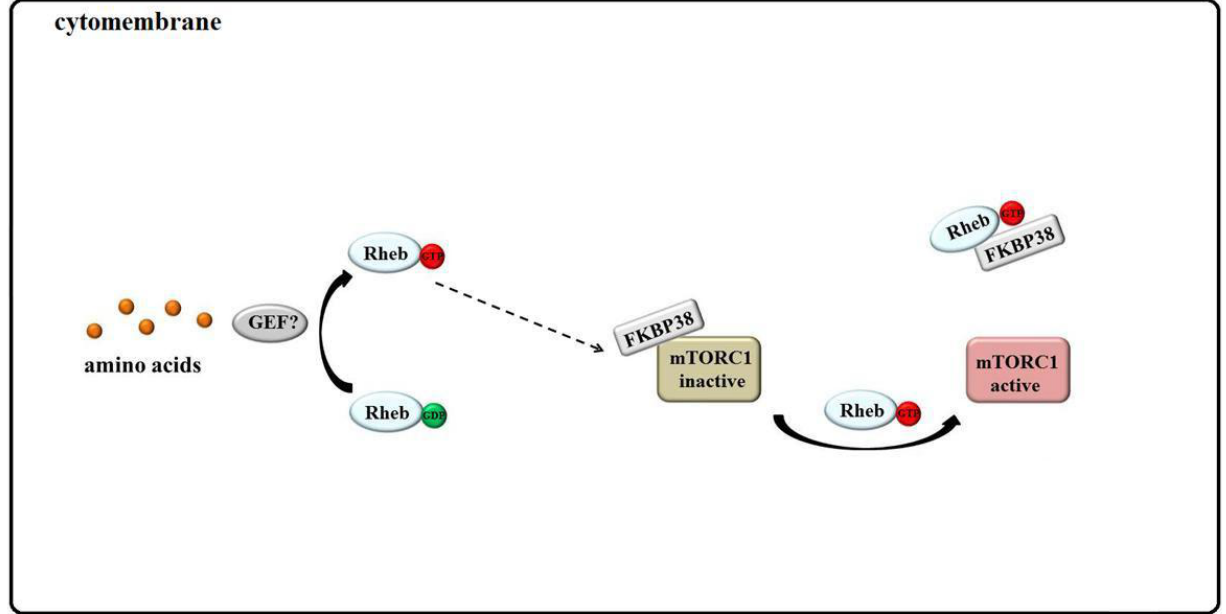
Figure 5. Model of mTORC1 activation by amino acids: “Rheb binds to FKBP38 and mTOR is unleashed.” Under conditions of ample amino acids, Rheb-GTP might interact with FKBP38 and induce the release and activation of